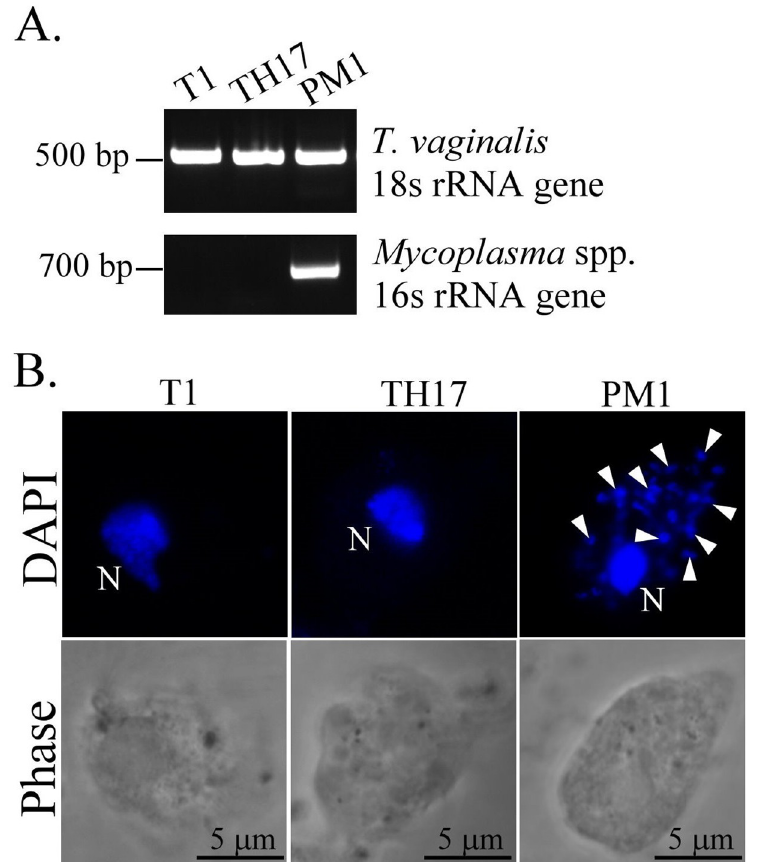
Fig 9. Mycoplasma symbiosis detection in the TH17 isolate. A. DNA extracted from T1, TH17, and PM1 isolates were amplified by PCR using specific primers for T . vaginalis 18s rRNA or Mycoplasma spp. 16s rRNA genes. The PCR products were separated in a 1% agarose gel. B. The trophozoites from T1, TH17, and PM1 isolates were fixed on a glass slide and stained with DAPI for confocal microscopy. The cell morphology was visualized by phase-contrast microscopy. The T . vaginalis nuclei are indicated by the letter N, and the Mycoplasma DNA puncta are indicated by white arrowheads. Scale bar represents 5 μ m.